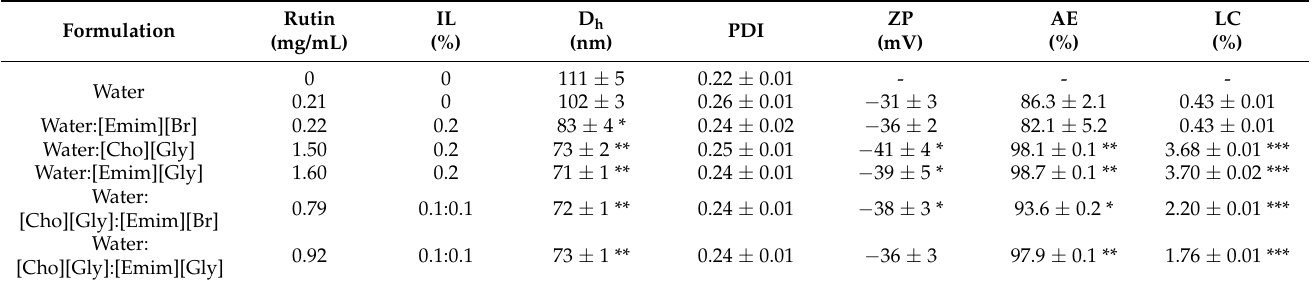
Table 4. Physicochemical properties of the produced transfersomes in the absence of rutin and IL, in the presence of rutin without IL, and in the presence of rutin with the ILs